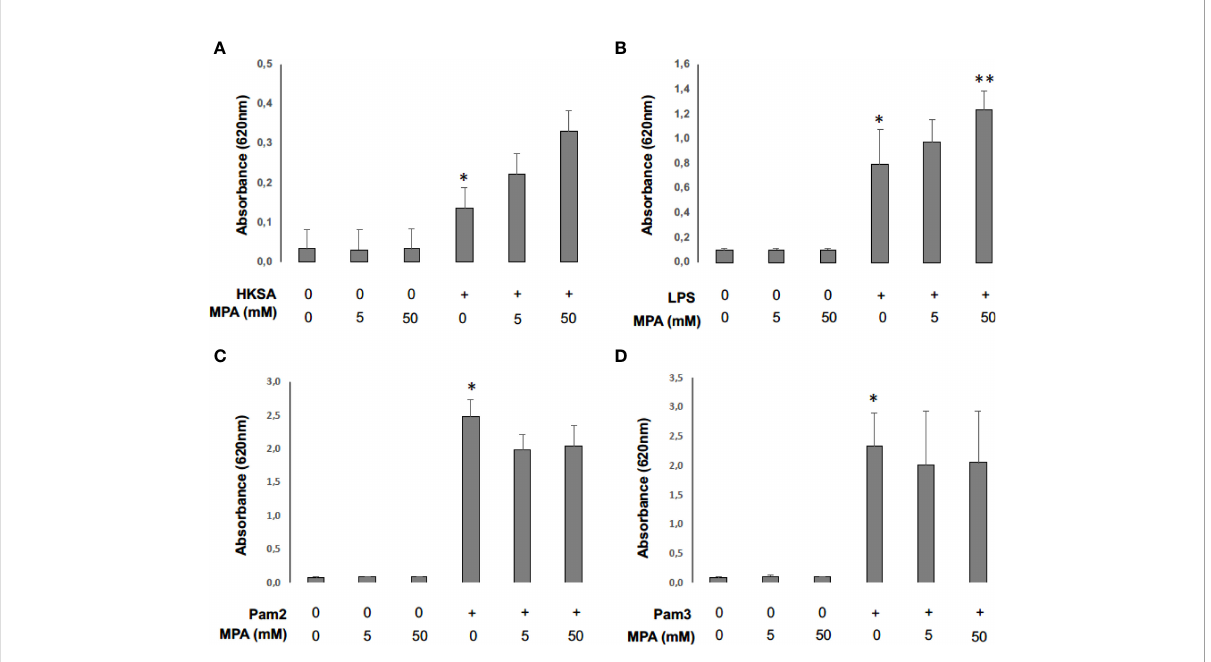
FIGURE 8 Mycophenolic acid potentiates NF- k B activity following monocyte cell-stimulation by S. aureus . THP1-Blue NF-kB cells (2. 10 5 cells) were incubated 24 hours at 37°C with CO2 5% with different concentrations of MPA and stimulated with HKSA (1 x 10 5 ) (A) , LPS (0.05ng/ m l) (B) , Pam2 (0,05ng/ m l) (C) or Pam3 (0,05ng/ m l) (D) . Optical density (OD) at 620 nm re fl ecting NF- k B activity was then read with EPOCH spectrometry in 96-well-plate. Differences between non-stimulated and stimulated conditions and between stimulated conditions with and without MPA were calculated using ANOVA with Tukey ’ s multiple comparisons tests. * represents P <0.05 between non-stimulated and stimulated conditions, ** P <0.05 represents P <0.05 between stimulated conditions with and without